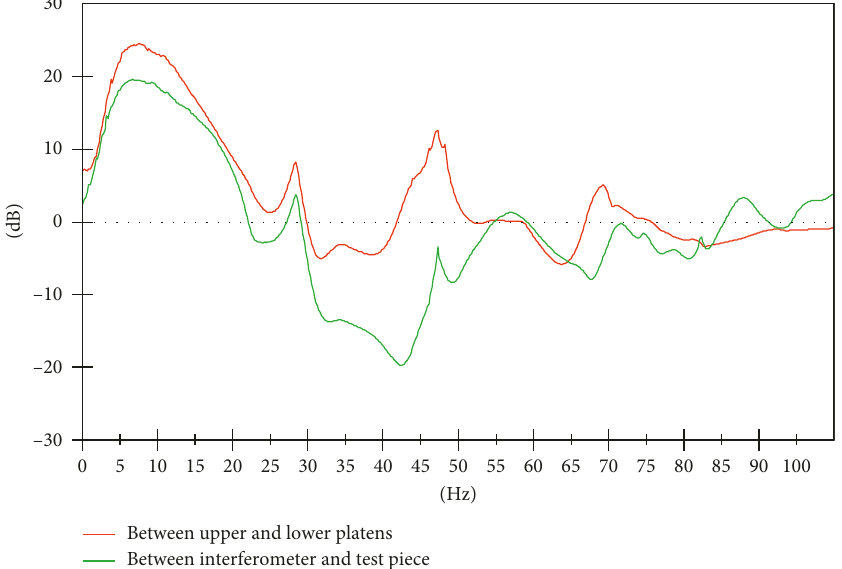
Figure 15: Comparison of the two transmissibility functions in Y